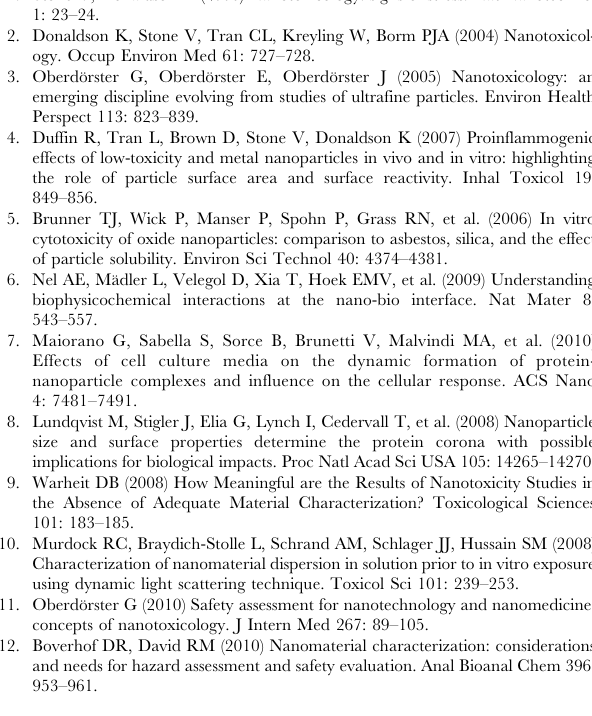
Table S1 Surface area, molar concentration, number of nanoparticles, mass of AuNPs in food and mass of AuNPs ingested from Drosophila per day relative to each size of AuNPs for TES (up) and TNN (bottom) approach. Table S2 List of primers used in RT-qPCR experiments. All primers were designed using on-line NCBI Primer-BLAST software. Table S3 Statistical analyses of the TES and TNN lifespan curves (top and bottom, respectively). TES statistical analyses reveal a significant difference between all the treatments compared to the control (CTRL). The comparison between CTRL and SN reveals a non significant difference (p-value . 0.05). TNN statistical analyses reveal an effective difference between all the treatments compared to the control (CTRL). The comparison between the treatments reveals a non significant difference (p- values .